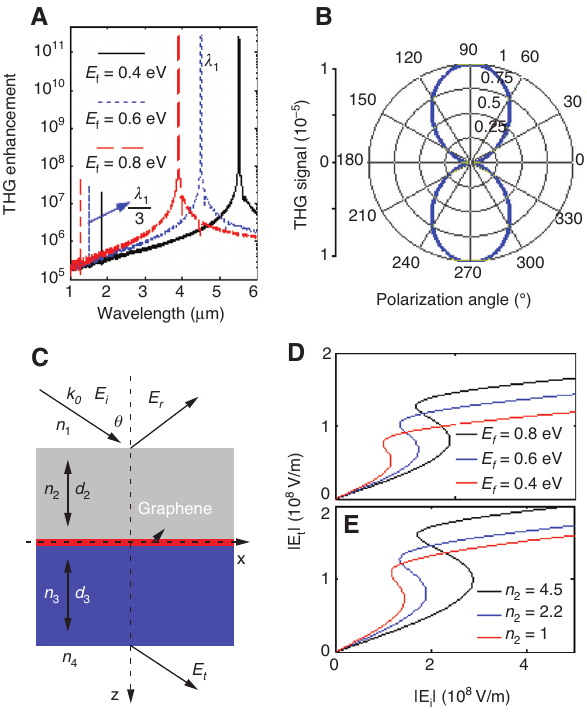
Figure 3: Polarization and Fermi energy dependent THG in sandwiched graphene sheet. (A) THG signal of total electric field energy (|E| 2 ) for three different = 0.4 eV, 0.6 eV, and 0.8 eV of FW mode at λ Fermi energies E f